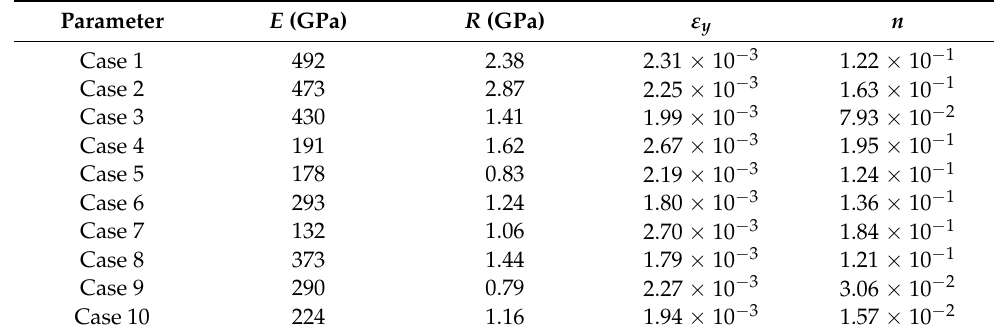
Table 1. The constitutive model parameters of the 10 specimens used in the model predictions. Figure 8. Comparison of predicted stress–strain responses by FE model and the proposed and LSTM neural network ( a , b ).